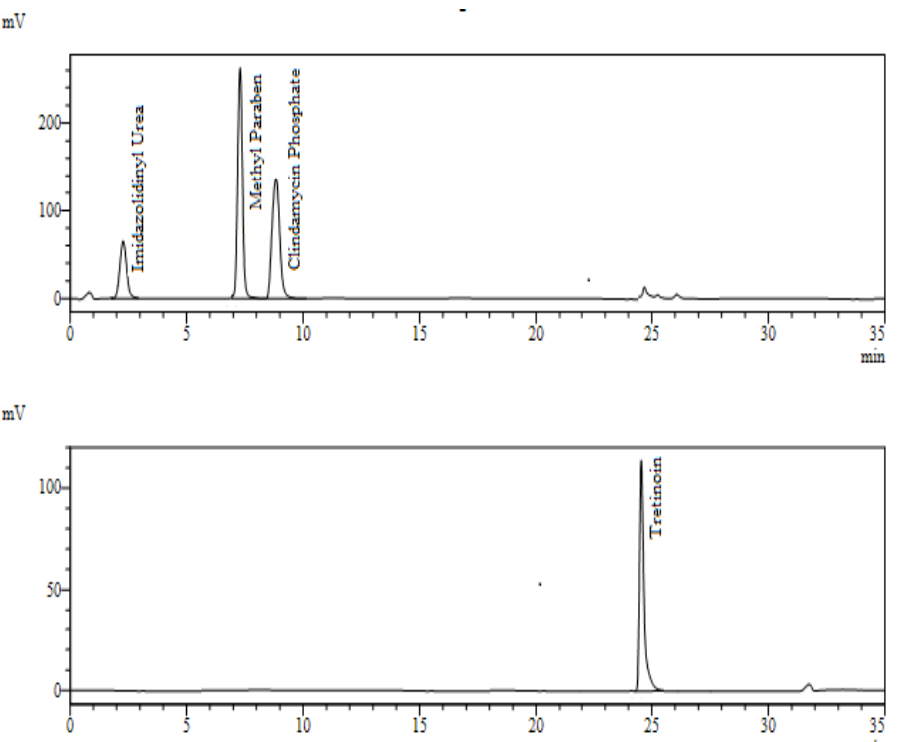
Figure 3. HPLC chromatogram of experimental gel preparation initial analysis. Peaks: imidazolidinyl urea, t R ∼ 2.2 min; methyl paraben, t R ∼ 7.3 min; clindamycin phosphate, t R ∼ 8.9 min; tretinoin, t R ∼ 24.8 min.